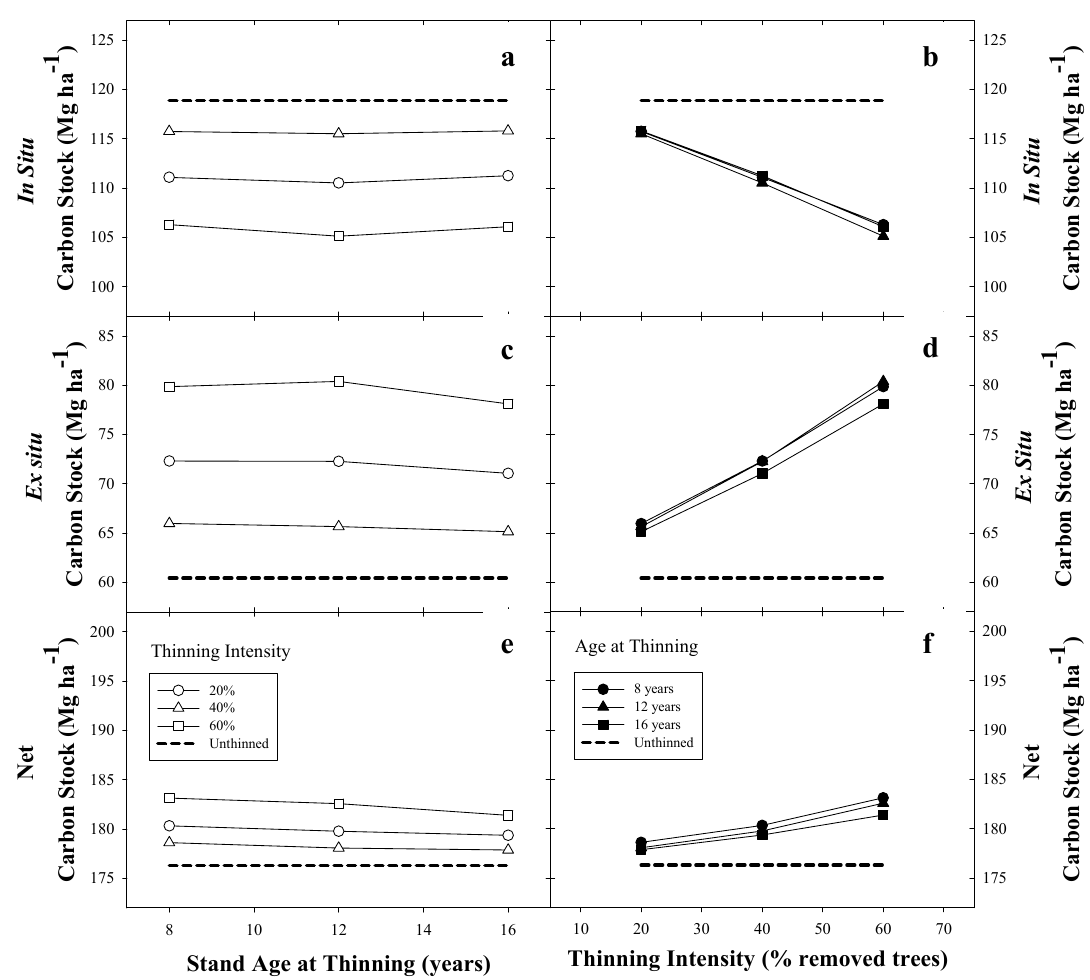
Figure 7. Effects of stand age at thinning ( a, c, e ) and thinning intensity ( b, d, f ) on In Situ , Ex Situ and average net C stocks for loblolly pine plantations over a ~200 year simulation